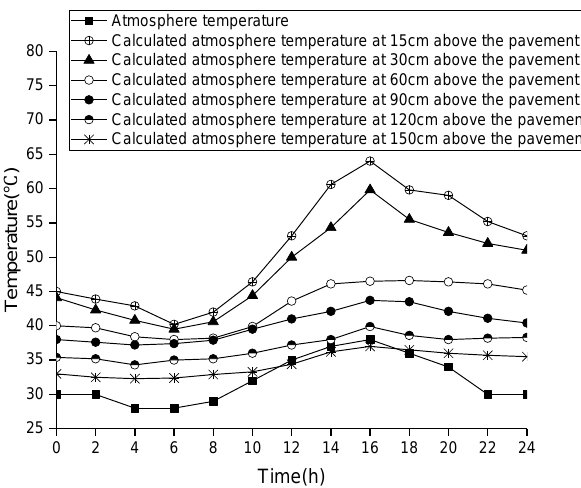
Figure 15. Diurnal variation of temperature at different heights from the road surface.